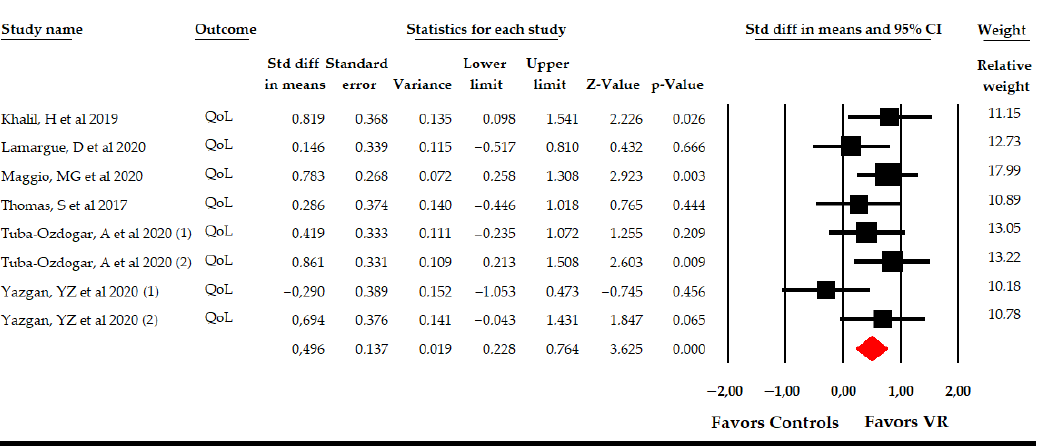
Figure 6. Forest Plot of the Effect of Virtual Reality on Overall Quality of Life.